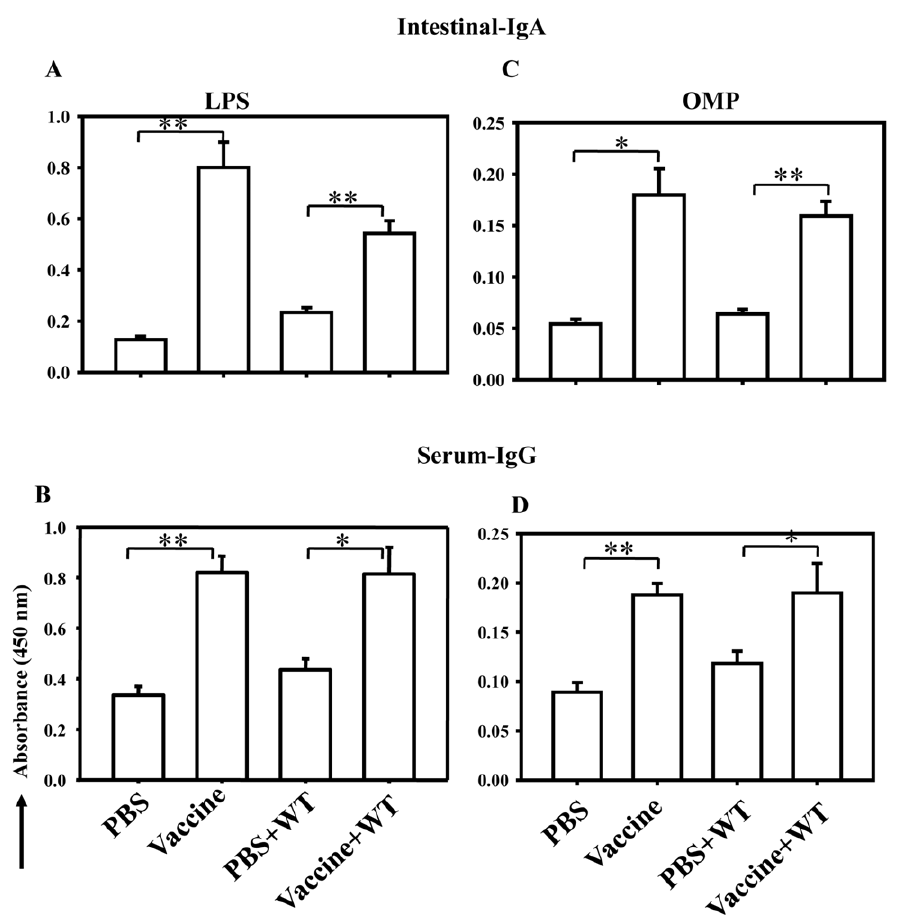
Figure 8. Humoral immune response elicited by single dose of vaccination with STM D hfq . Group of mice were orally given PBS or STM D hfq (10 8 ) and then challenged with STM-WT (10 7 CFU/mouse) at day 7 of post vaccination. Serum and intestinal mucus were collected on 7 th day post vaccination (from unchallenged mice) and 7 th day post challenge (from challenged mice). Serum IgG (B&D) and intestinal S-IgA (A&C) antibodies specific for LPS and OMP were measured by ELISA. The samples were assayed in triplicate and the antibody titer is expressed as the absorbance at 450 nm. Data is representative of two independent experiments. Statistical significance was defined as follows: (*p , 0.05; ** p , 0.005) (Student’s t test). (n=4-5).